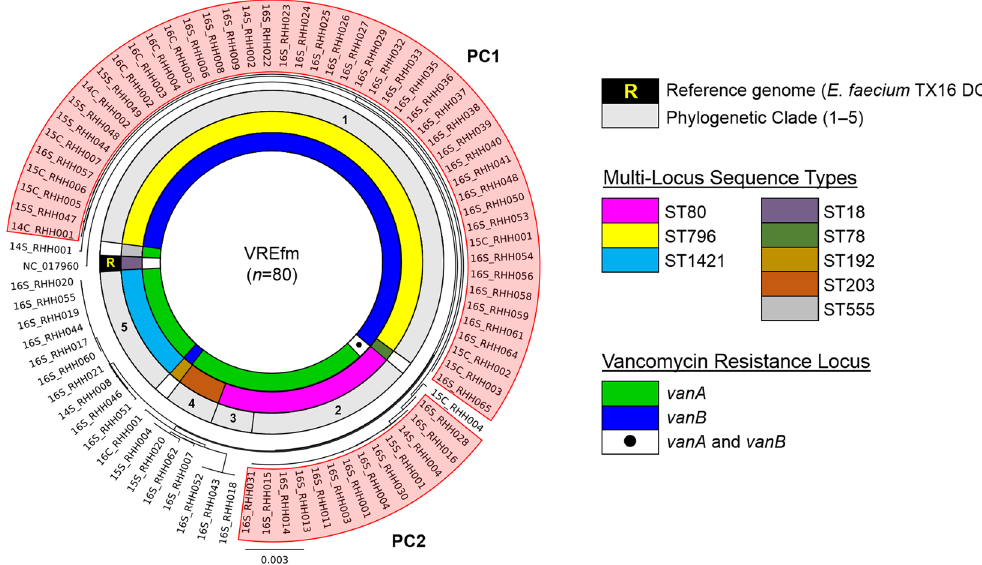
Figure 3. Phylogenetic analysis of vancomycin-resistant Enterococcus faecium (VREfm) isolates collected from patients at the Royal Hobart Hospital from 2014–2016 that underwent whole-genome sequencing ( n = 80). A SNP-based maximum-likelihood (PhyML) phylogenetic tree was generated using E. faecium DO TX16 as the reference genome (NC017960) to root the tree. Branches of the phylogenetic tree revealed five major phylogenetic clades (PC). The whole genome data enabled in silico determination of multi-locus sequence types (MLST) and vancomycin resistance